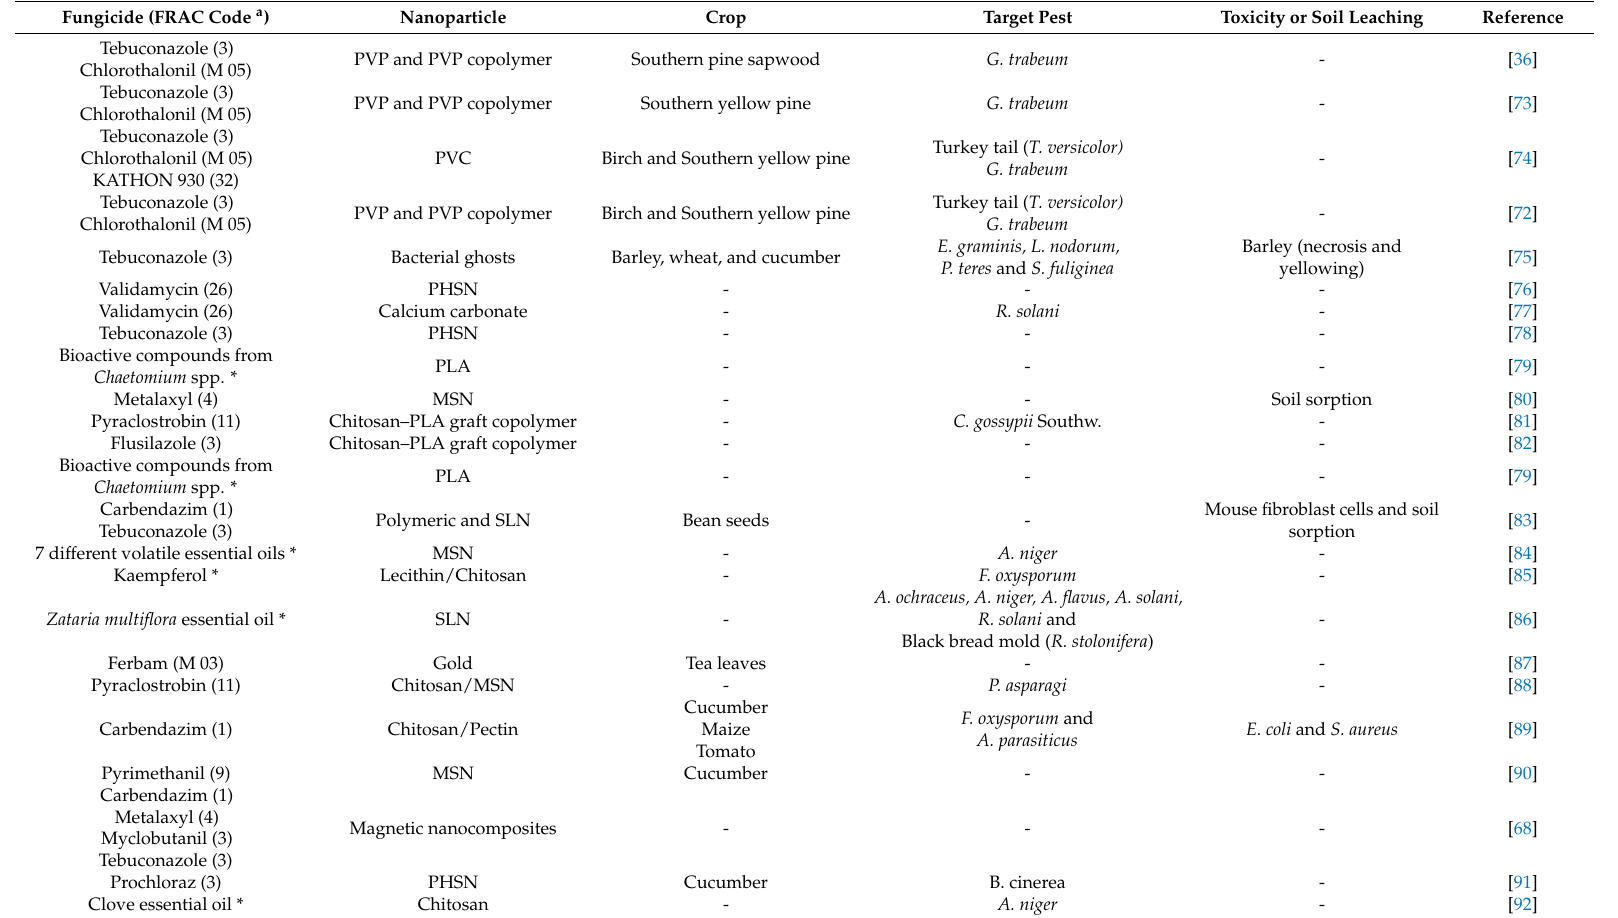
Table 2. Summary of studies utilizing nanoparticles as carriers of fungicides or actives that target